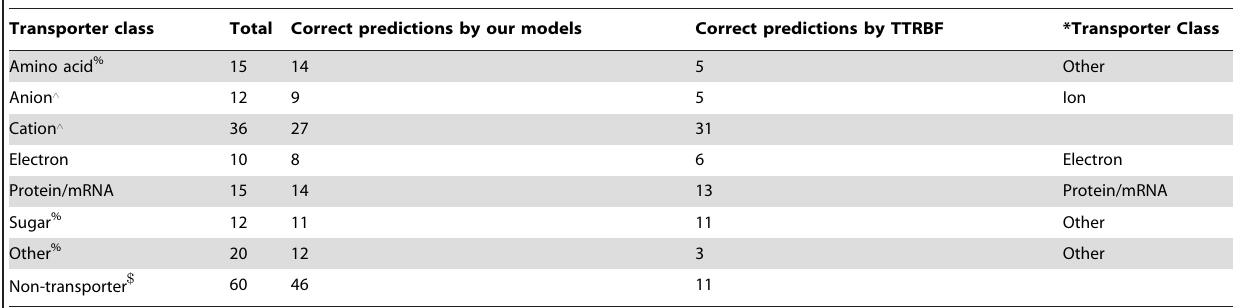
Table 4. A comparison of the performance of our model with TTRBF.